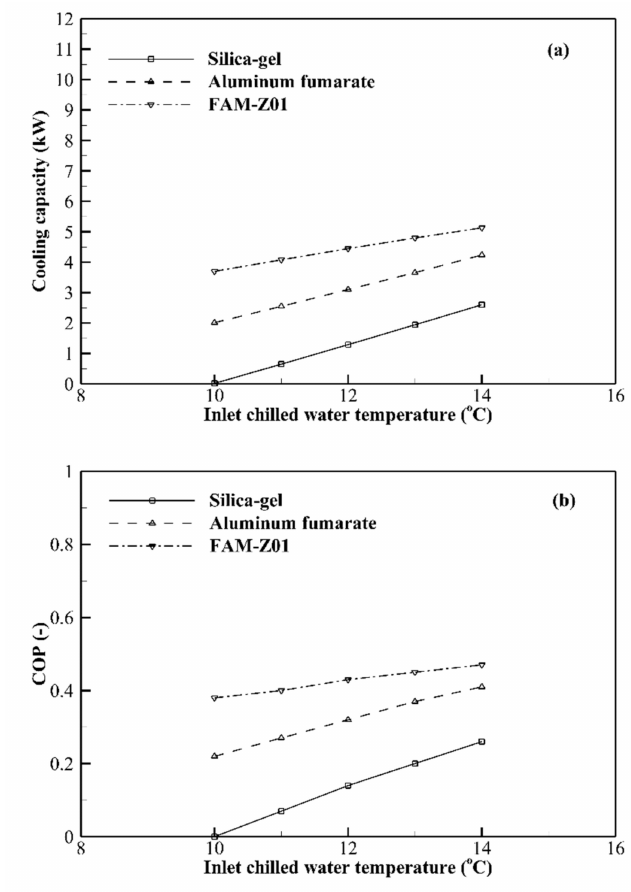
Figure 8. Influence of inlet chilled water temperature on: ( a ) cooling capacity and ( b )